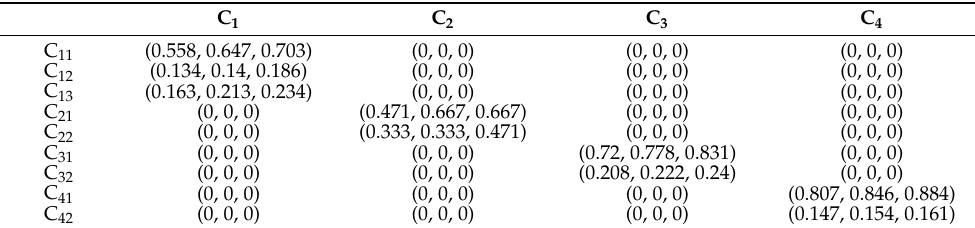
Table 8. Pairwise comparison matrix of sub-criteria with respect to the economic